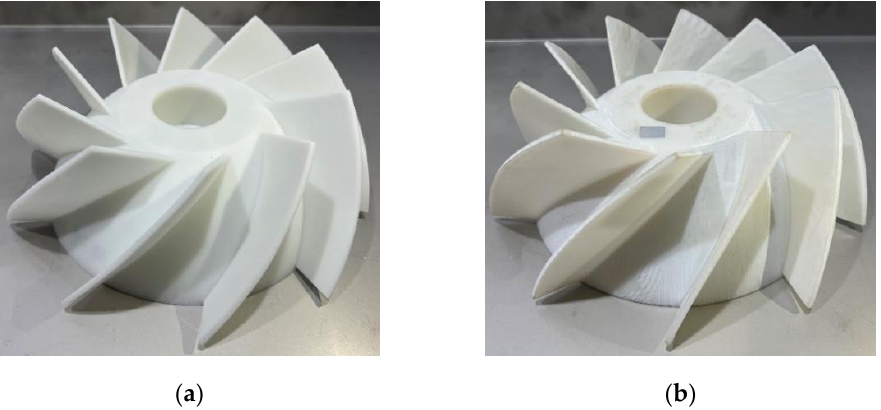
Figure 19. Comparison diagram of impeller before and after optimization. ( a ) Original. ( b ) Optimized. After the air performance test, the optimized and original fan performance curves were plotted on the same diagram to visually compare their performance changes, as shown in Figure 20.